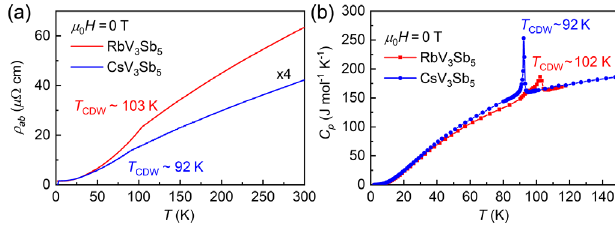
FIG. 5. (a) and (b) show transport and specific heat measure- ment of RbV 3 Sb 5 (red) and CsV 3 Sb 5